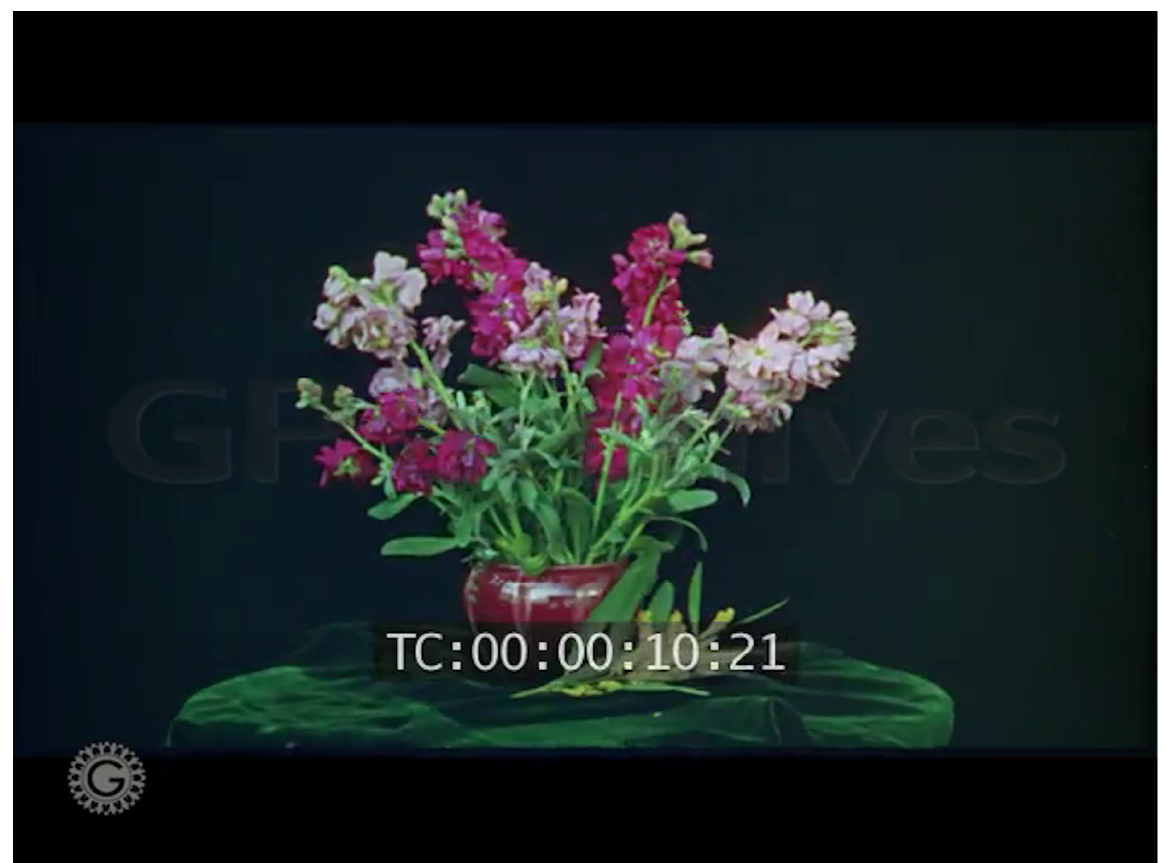
Figure 1. Film still from Bouquets dans des vases , Gaumont, 1912 (© Gaumont Pathé Archives). However, to think about cinema with plants is not necessarily to focus on represen- tation alone 8 . To return to Étude des fleurs and Bouquets dans des vases , the most relevant aspect of these pictures concerns our perception of their colours and what they tell us about filmic flowers. If their vibrant hues strike us as nonnatural (in particular the chrono- chrome florae of Bouquets dans des vases ), it is probably because of the synthetic, celluloid character of these specimens—yet another iteration of what Sarah Cooper has aptly named